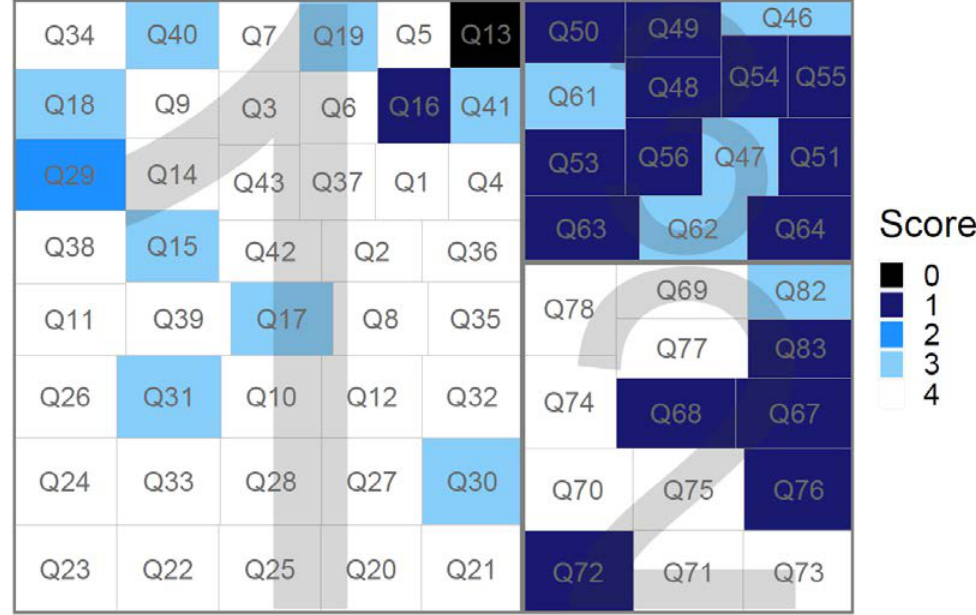
Figure 6. TreeMap of the questionnaire. The colors represent the most common scoring for each question. The higher the factor loading, the larger the area of the rectangle. Each factor has its own set of questions (1, 2 or 3).